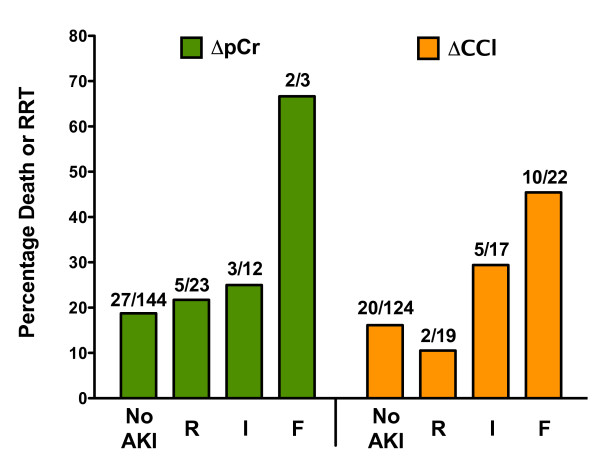
Comparison of plasma creatinine (pCr) change with estimated creatinine clearance (CCl) change acute kidney injury (AKI) severity classes (No-AKI, R, I or F) on entry to the ICU in the known baseline creatinine cohort. Percentage of patients who died or needed dialysis; ΔpCr, P = 0.12, ΔCCl, P = 0.0055 (χ2 test for trend). The number above each bar is the number of patients who died/total number.